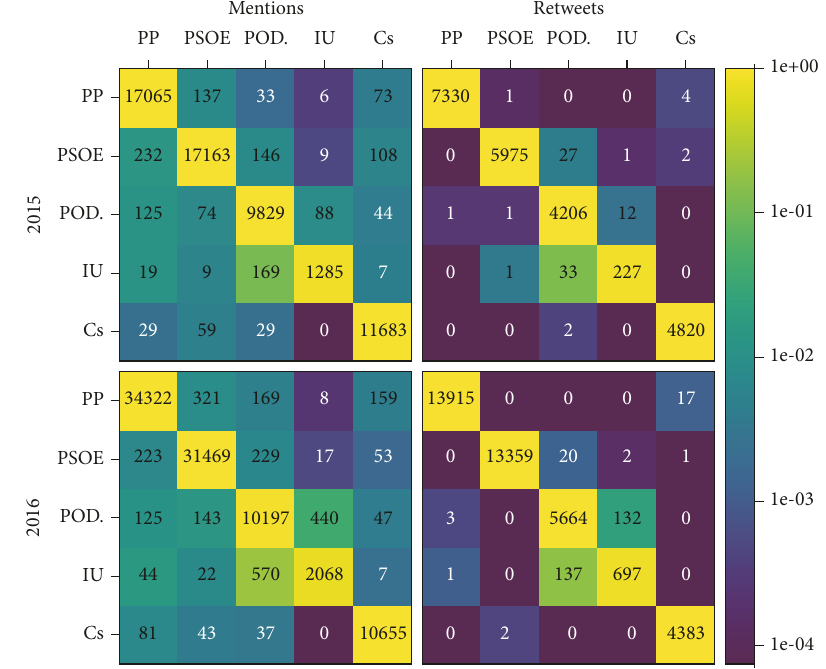
Figure 10: Adjacency matrices of C-networks where each supernode is the aggregation of political accounts belonging to a given party. Left panels correspond to mention networks and right panels to retweet networks. Top panels correspond to results of 2015 and bottom panels to results of 2016. Color is related to the proportion of mentions (retweets) directed from party 𝑖 (row) to party 𝑗 (column) by the following formula: 𝑐 𝑖𝑗 = 𝐴 𝑖𝑗 /∑ 𝑗 𝐴 𝑖𝑗